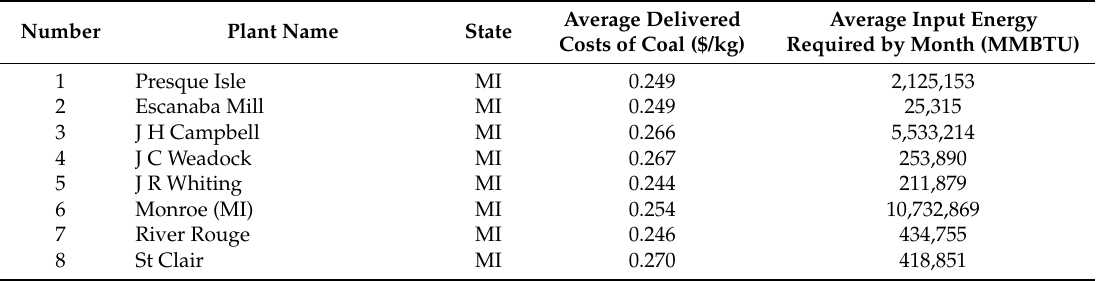
Table 2. Names, states, delivered costs, and input energy required by coal power plants